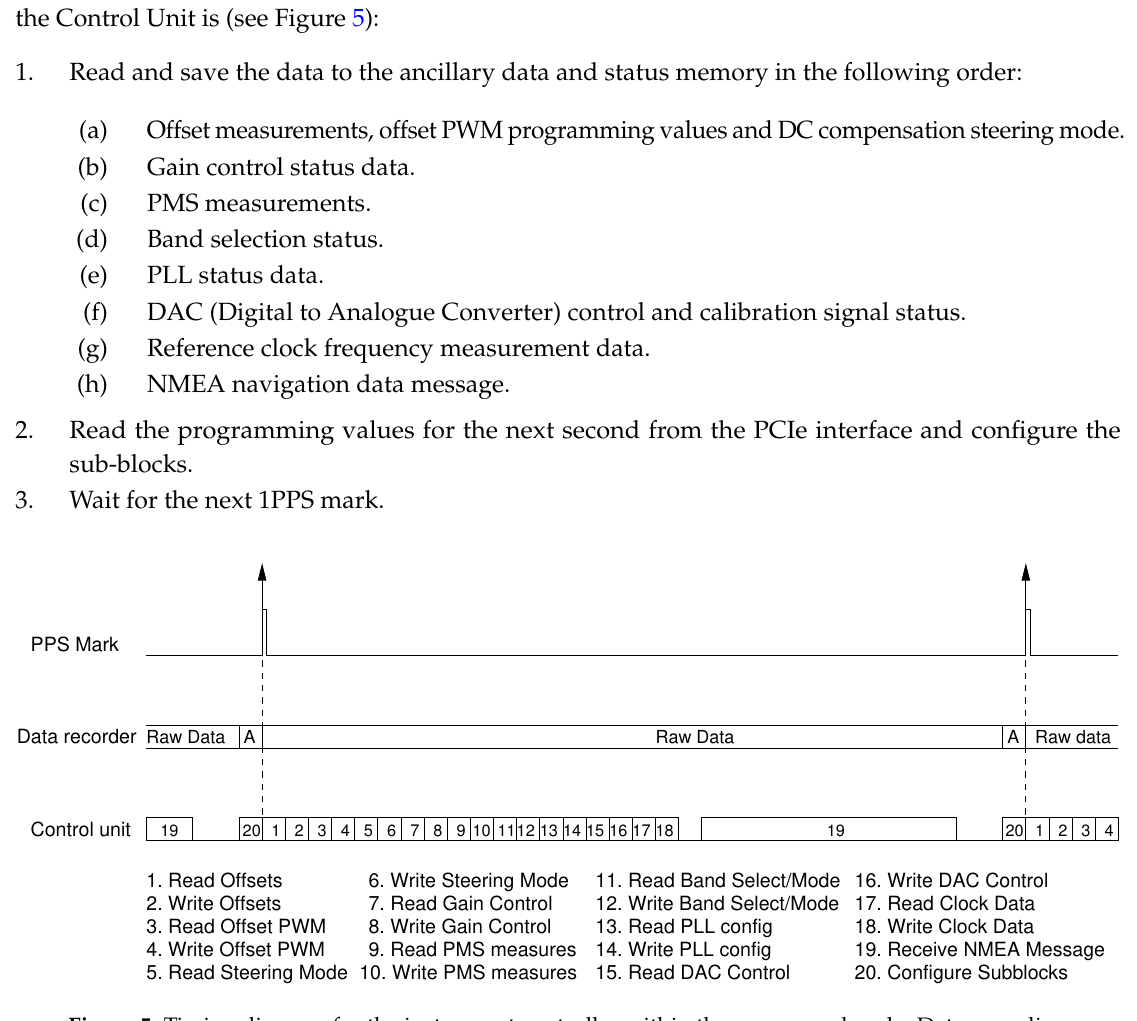
Figure 5. Timing diagram for the instrument controller within the one-second cycle. Data recording and instrument control are done simultaneously and are started synchronously with each 1PPS mark. Raw data is recorded during from the beginning of each second, while ancillary data is saved at the end of each second (indicated with an “A” in the figure). Instrument control is carried out in a sequential way by different control